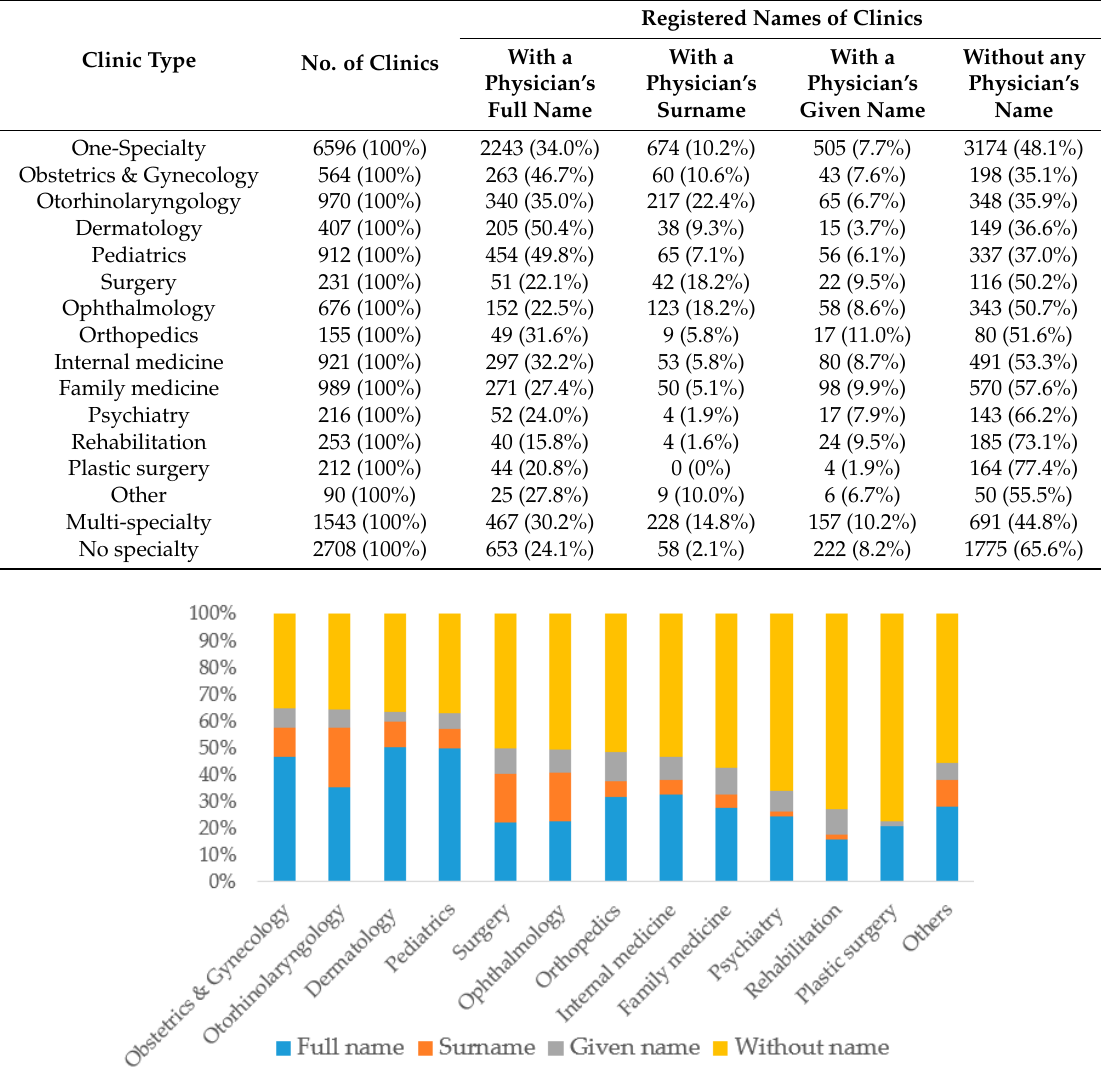
Figure 2. Proportion of the four types of registered names in different one-specialty clinics.